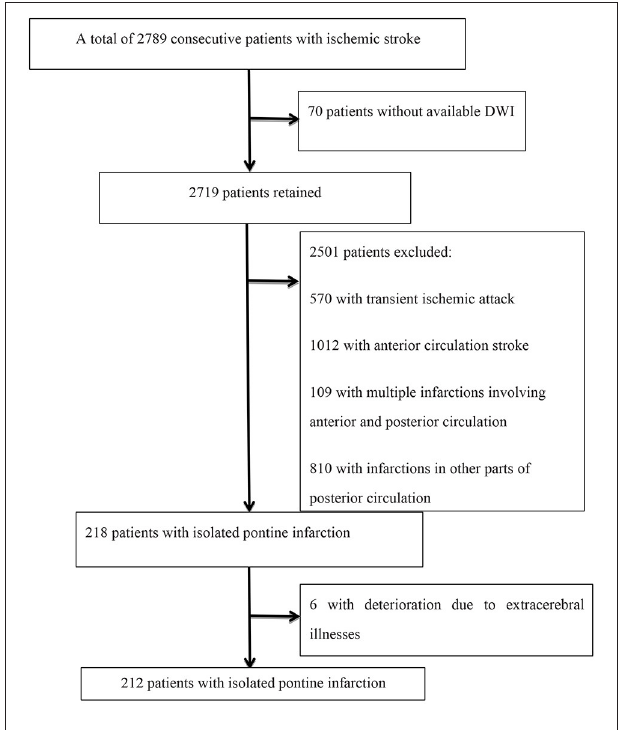
FIGURE 1 | Flowchart of study population inclusion and